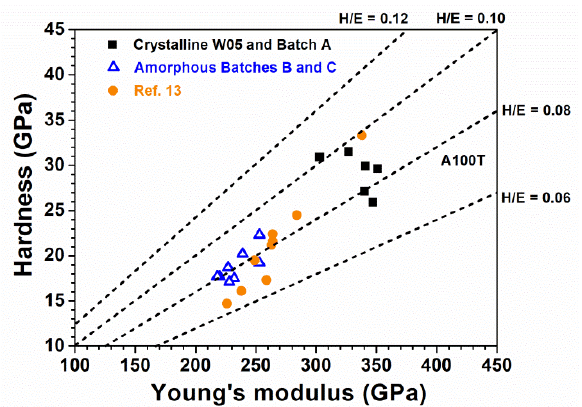
Figure 8. Relationship between H and E of the W–N and W–Si–N films.